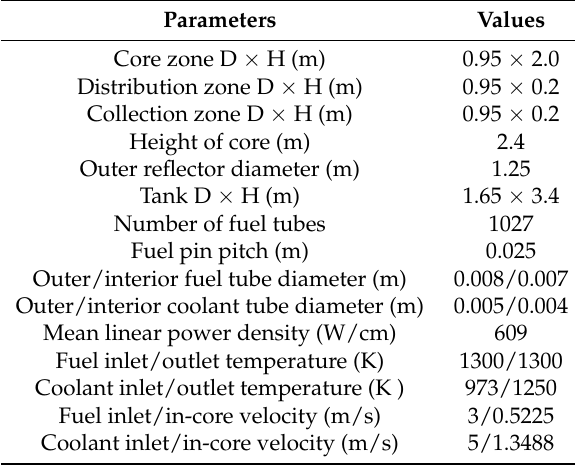
Table 1. SMDFR technical